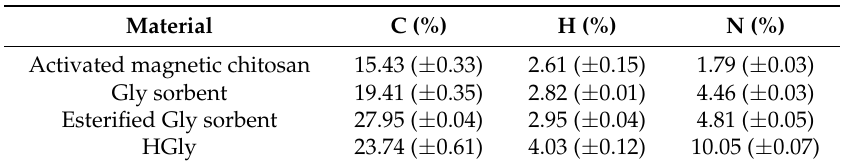
Table 1. Elemental analysis of the sorbents Gly and HGly (together with activated magnetic chitosan and esterified-glycine